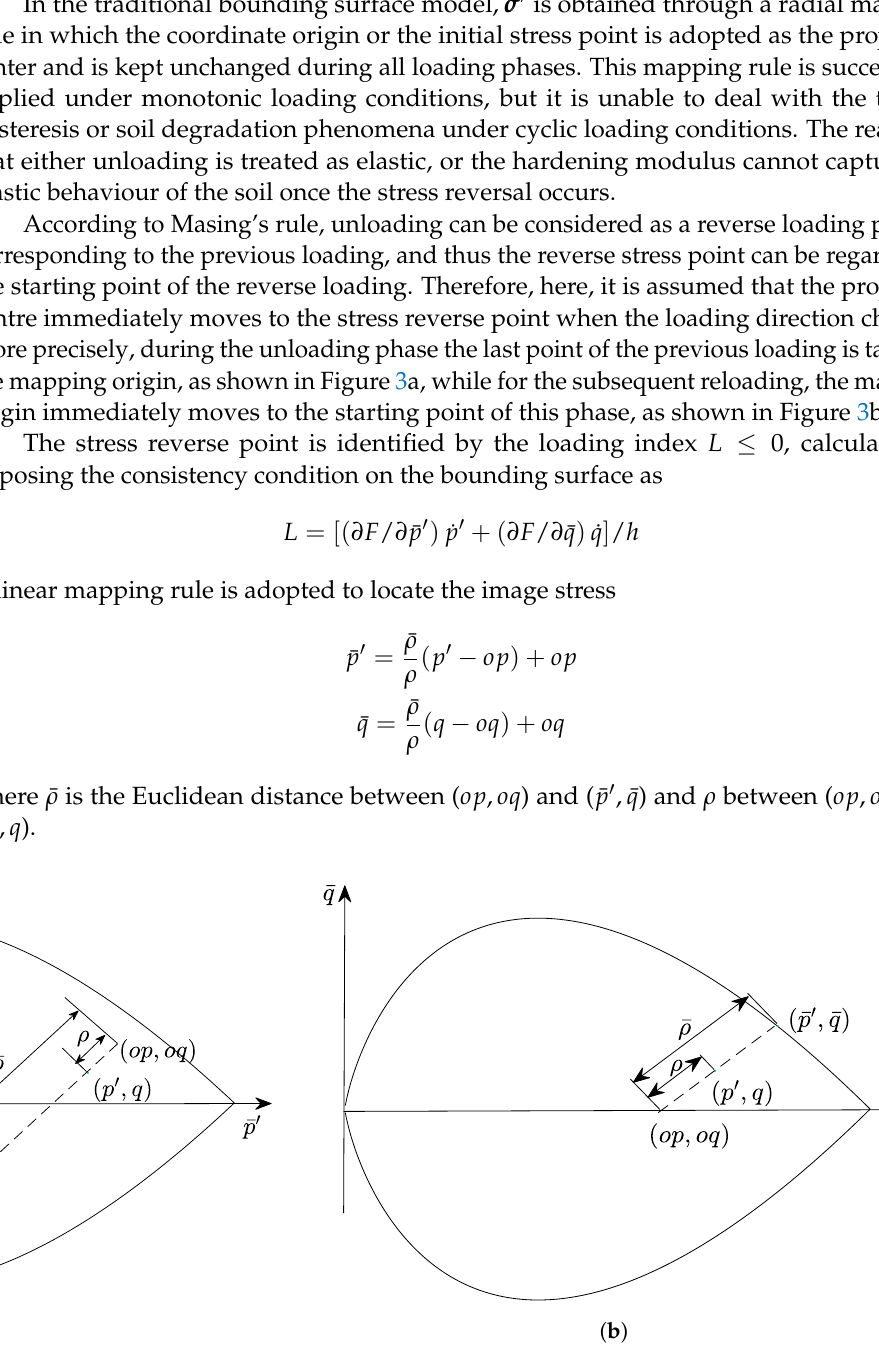
Figure 3. Mapping rule and projection centre at different loading stages: ( a ) unloading and ( b )